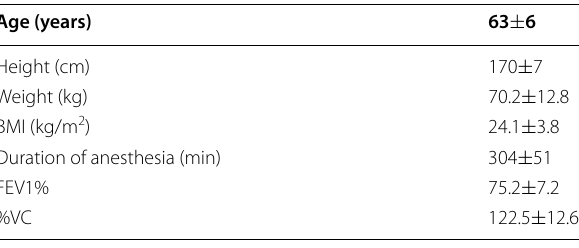
Data are presented as the mean